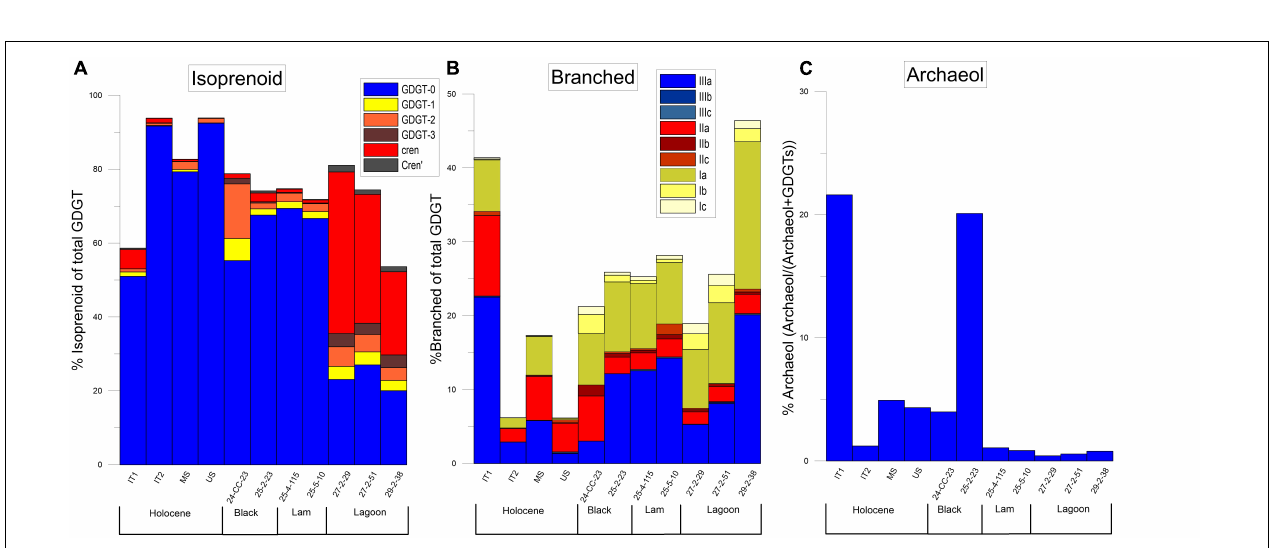
FIGURE 4 | Bar charts showing the relative amount of each GDGT compound. All compounds are shown as percent of total GDGT in sediment. (A) %Isoprenoid. (B) %Branched. (C) Percentage of Archeol compared to total amount of GDGT lipids. Black layers, laminated (Lam) sediments, and paleo-lagoon sediments are indicated for the Miocene